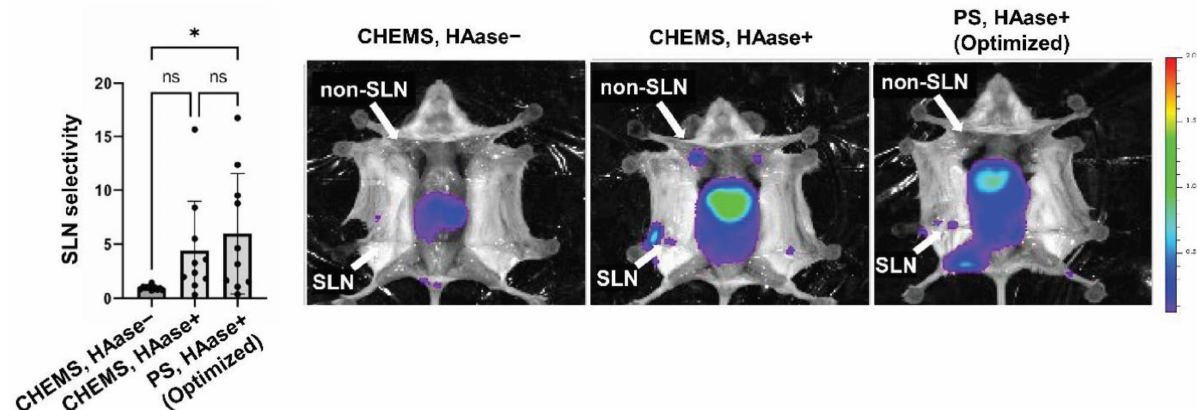
Figure 4. SLN imaging by the optimized liposomes. Mice were treated with liposomes in the presence or absence of HAase, and then imaged with an IVIS imaging system. Inguinal LN and axillary LN were considered SLN and non-SLN, respectively. *: p < 0.05, ns: not statistically significant ( n = 10).